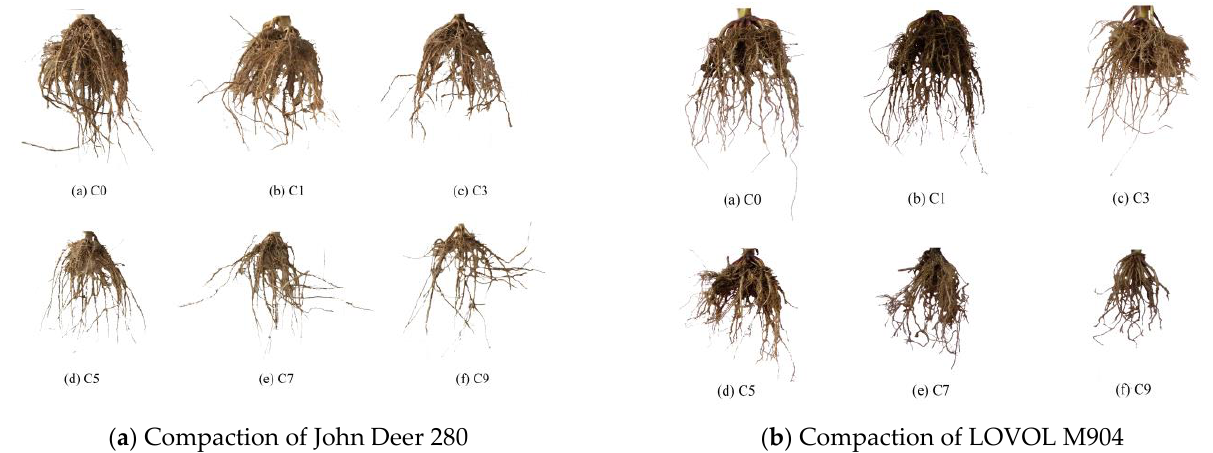
Figure 8. The shape of maize roots under different loads and times of compaction.